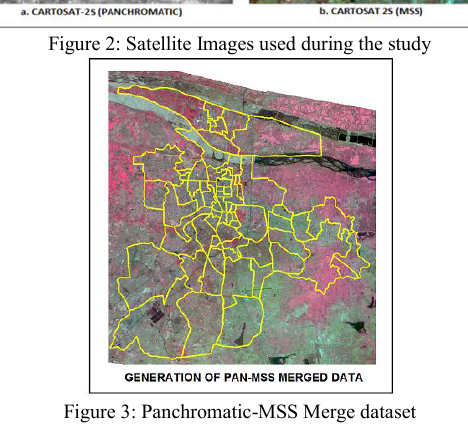
Figure 3: Panchromatic-MSS Merge dataset